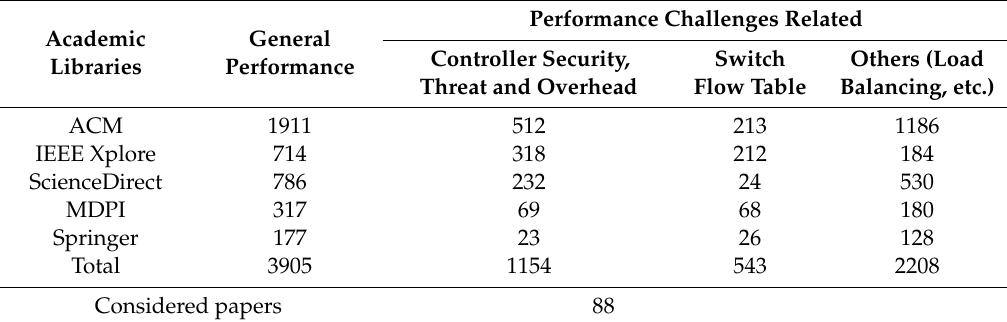
Figure 5. Taxonomy of software defined networking (SDN) performance Challenges. Table 1. Number of article publications from research